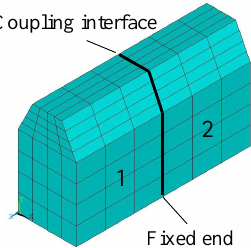
Figure 8. Finite element model of elastic